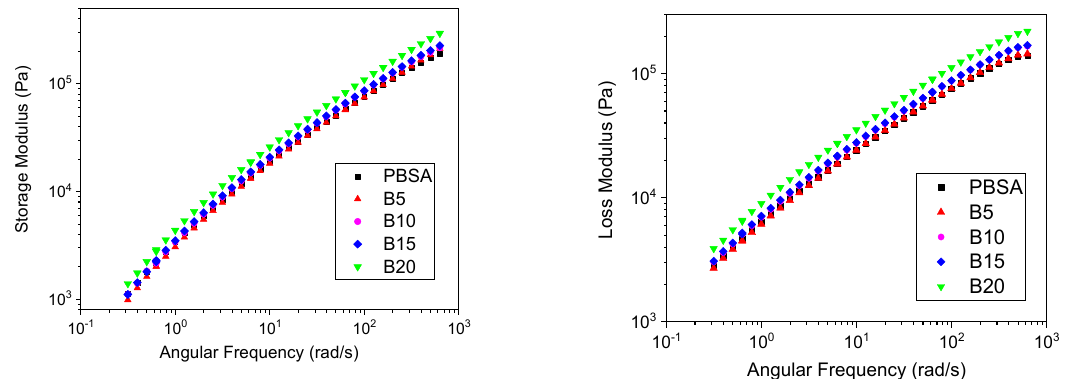
Figure 6. Storage ( G ′ ) and loss ( G ″ ) moduli versus angular frequency for the PBSA and PBSA/B composites (B5, B10, B15, and B20) at 145 °C.